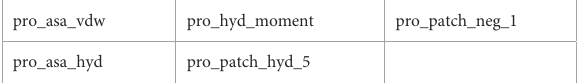
TABLE 11 5 features out of 50 were selected having a feature score of four using the feature scoring table for